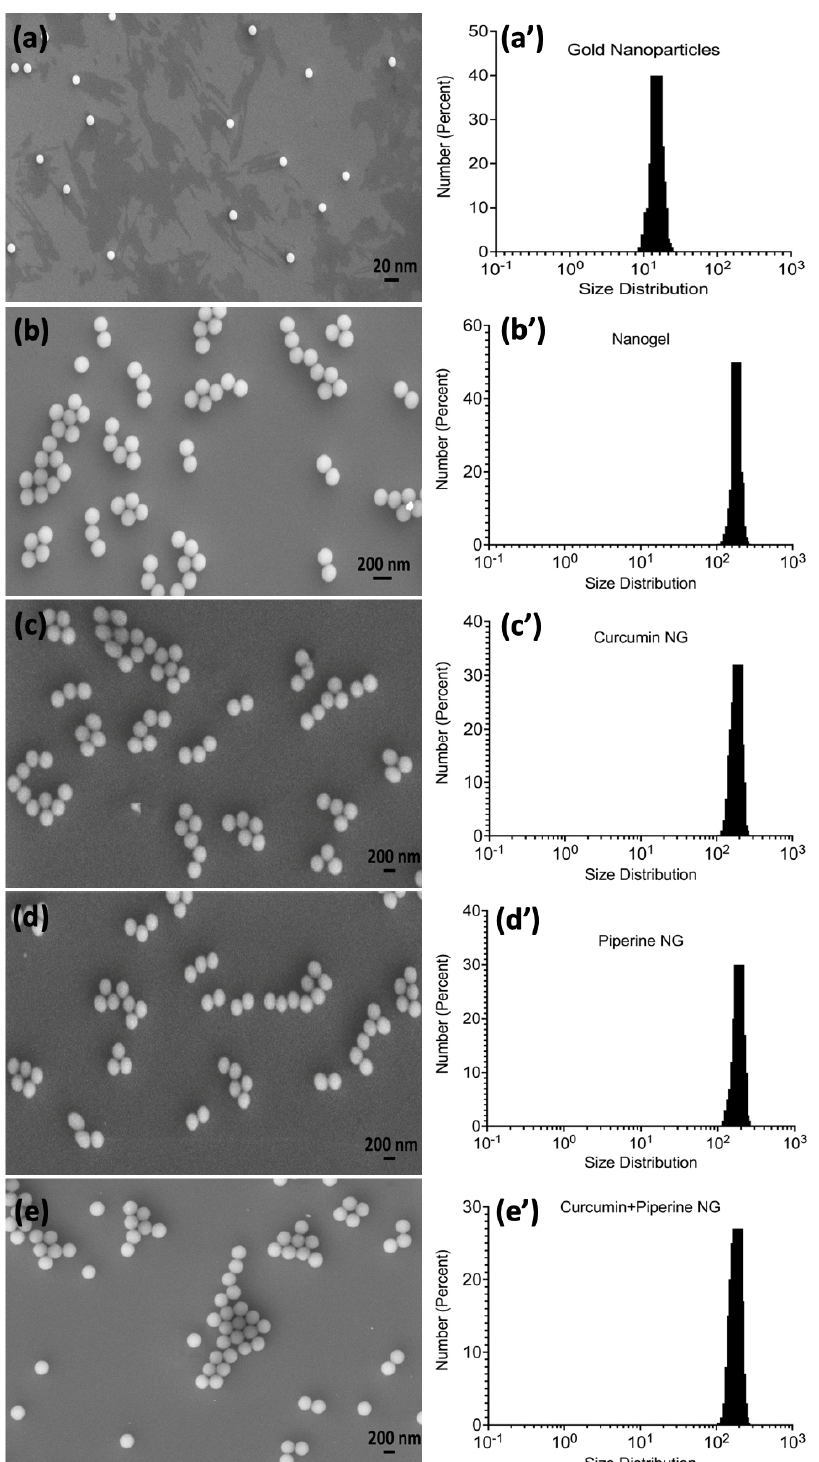
Figure 2. A scanning electron microscopic images and size distribution analysis of nano-formulations; ( a ) gold nanoparticles; ( b ) gold nanoparticles and nanogel; ( c ) curcumin-loaded gold nanogel; ( d ) piperine-loaded gold nanogel; ( e ) hybrid curcumin–piperine-loaded gold nanogel; ( a’ ) size distribu- tion analysis of gold nanoparticles; ( b’ ) size distribution analysis of nanogel; ( c’ ) size distribution analysis of curcumin-loaded nanogel; ( d’ ) size distribution analysis of piperine-loaded nanogel; ( e’ ) size distribution analysis of curcumin–piperine-loaded